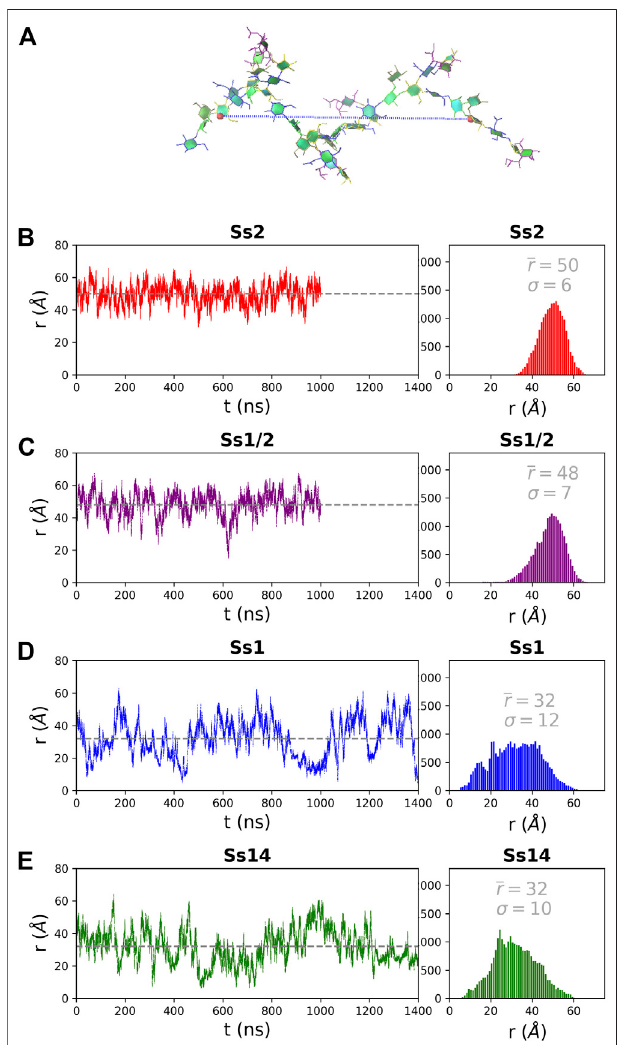
FIGURE 2 | The end-to-end distance, r , for the 6 RU S. suis CPS is here de fi ned as the distance (Å) from the ring O5 in the backbone β DGal in the fi rst andlastRU,labelledin (A) onasampleSs2conformation.Thesimulationtime series (left column) and corresponding histograms (right column) are graphed for (B) Ss2, (C) Ss1/2, (D) Ss1 and (E) Ss14. The fi rst 200 ns of simulationareconsideredequilibrationandarenotshown.Theaverage r value (cid:1) r (plotted as a dashed gray line on the time series graphs) and the standard deviation σ are listed on each